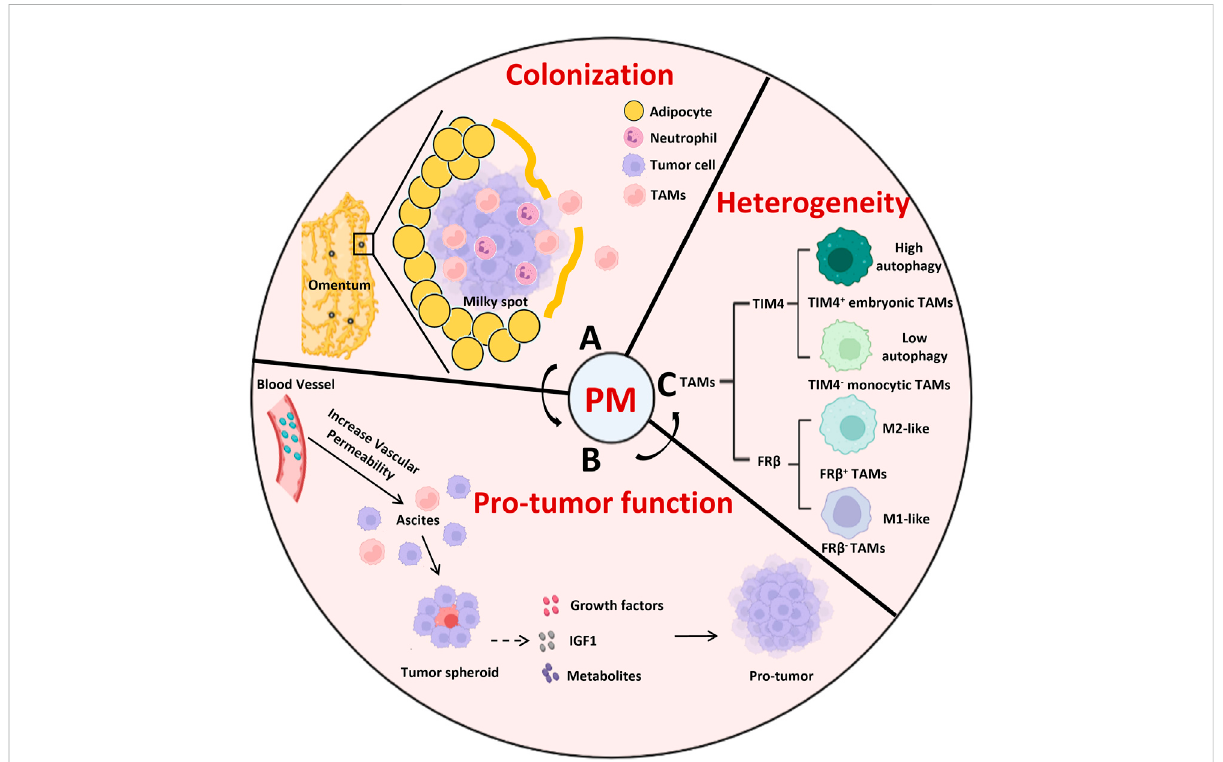
FIGURE 2 Theroleofperitonealresidentmacrophagesinthetumormetastasisintothecavity. (A) Thecolonizationofomentumisacriticalstepfortumor metastasis, which isoccurredpassivelythrough themilkyspots. (B) TAMs promote thetumorperitonealmetastasis throughgatheringtumor cellsto form the spheroid and secreting growth factors, IGF1, metabolites to support the tumor growth. (C) The heterogenicity of TAMs distinguished by TIM4 orFR β in peritoneal metastasis.Comparedto TIM4 - monocytic TAMs, TIM4 + embryonic TAMs express more OXPHOS genesand adapt to autophagy to support their survival. FR β − TAMs display a round shape that was more monocytic in appearance and consistent with M1 phenotype while FR β + TAMs exhibited an elongated cell shape with a M2-polarized pro-tumor pro fi les. IGF1, insulin-like growth factor 1; PM, peritoneal metastasis; TAMs, tumor associated